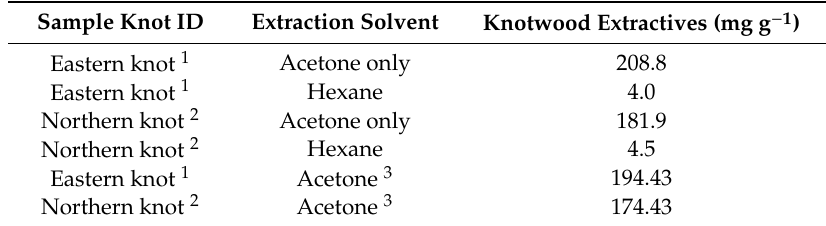
Table 2. The amounts of extractives in the acetone and hexane extracts in the knotwood samples. Location of the sample in the crown is